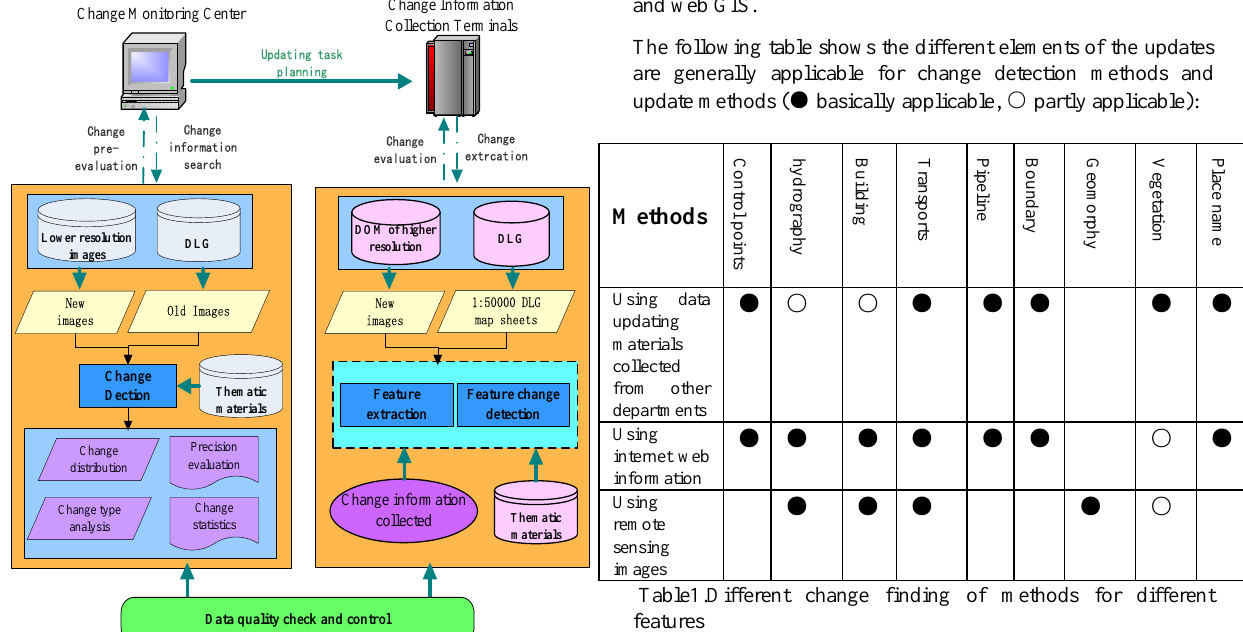
Figure5. Change detection for topographical features updating from imagery